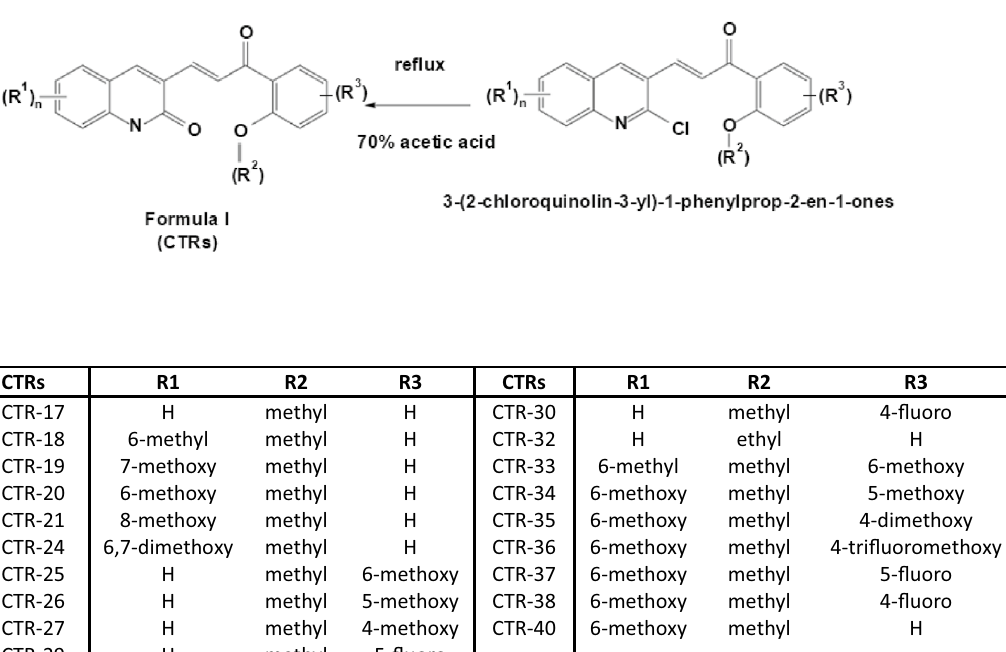
Melanoma cell lines Breast cancer cell lines